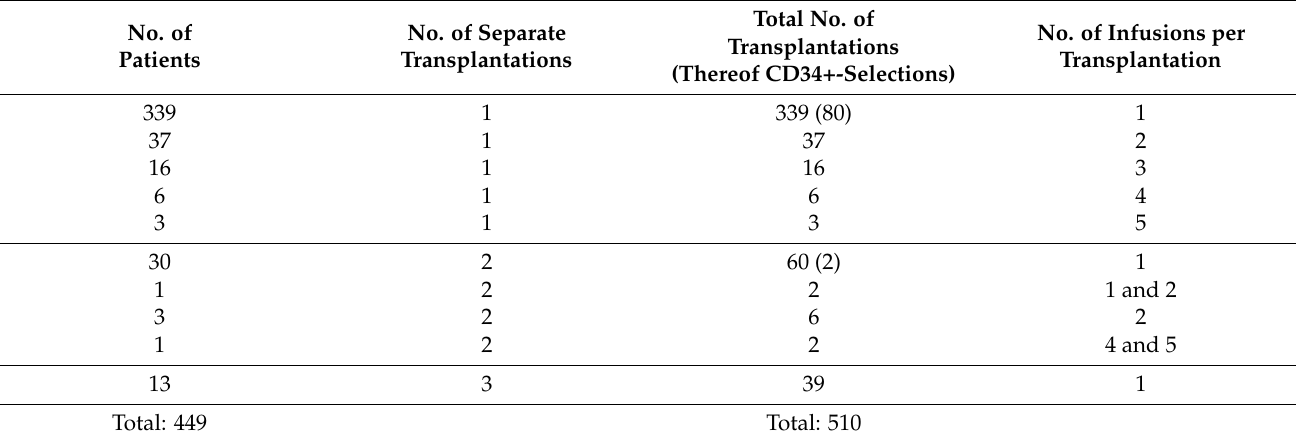
Table 2. Distribution of